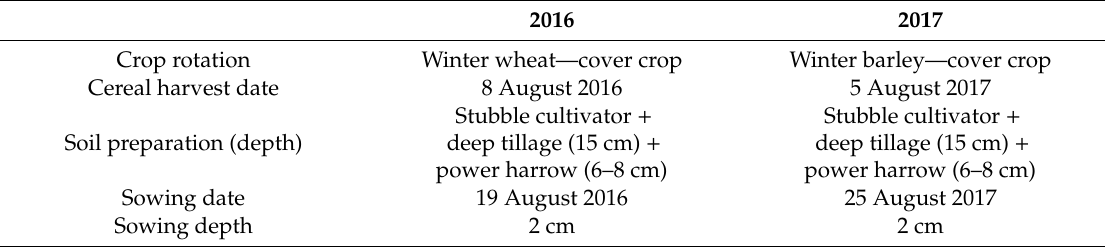
Table 1. Experimental set-up and conditions for the field trials in Southwest Germany in 2016 and 2017.